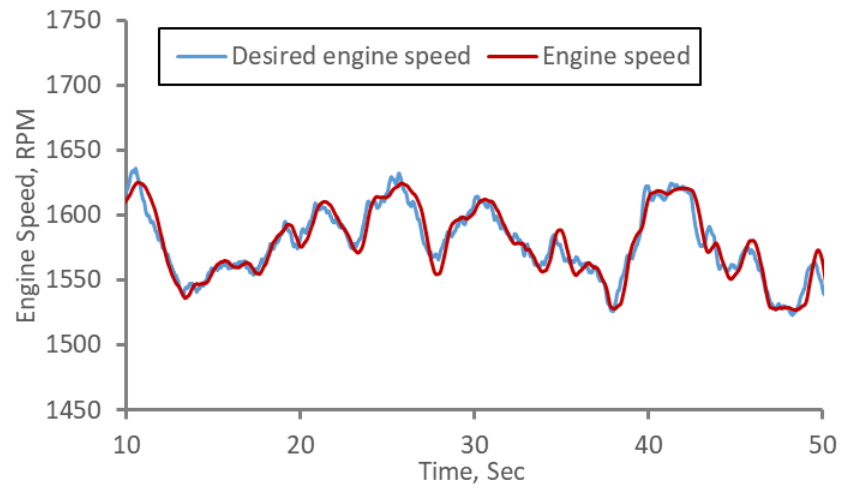
Figure 12. Simulation results of engine speed controller using actual load data.